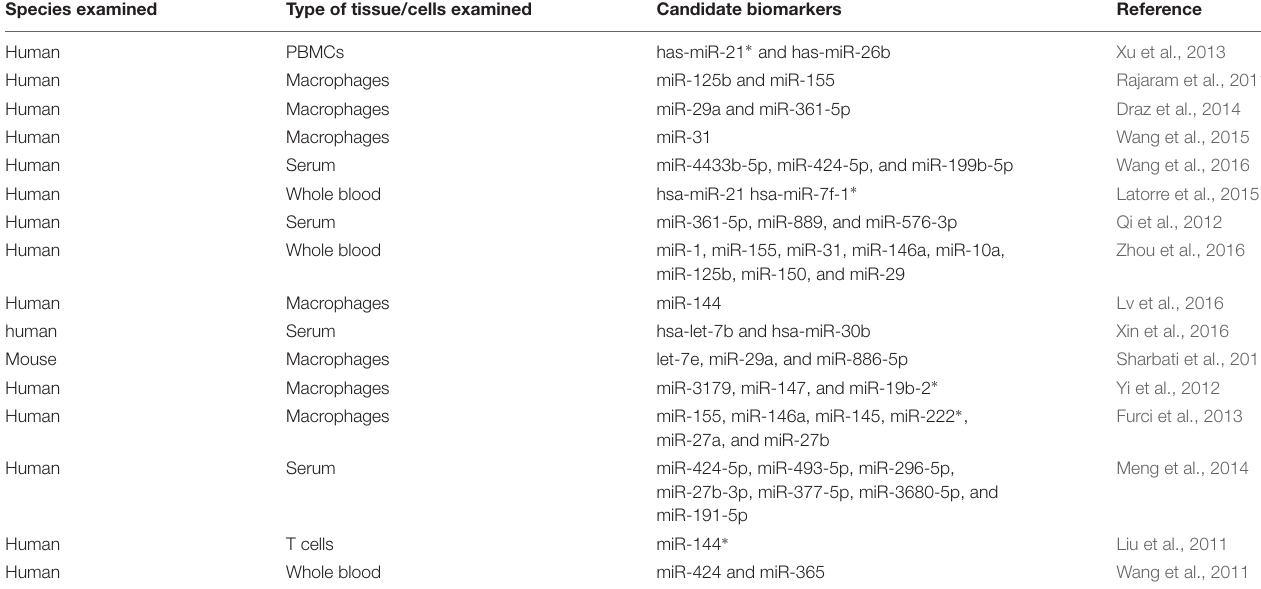
TABLE 1 | Differential expression of miRNAs in tuberculosis and their potential as